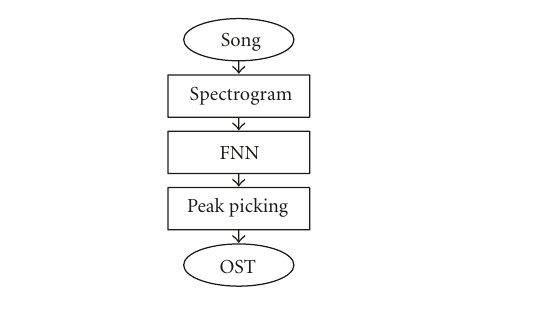
Figure 2: SINGLE-NET flowchart. This simpler variant of our algo- rithm is comprised of a time-space transform (spectrogram) which is in turn treated with a feed-forward neural network (FNN). The resulting trace is fed into a peak-picking algorithm to find onset times (OSTs).